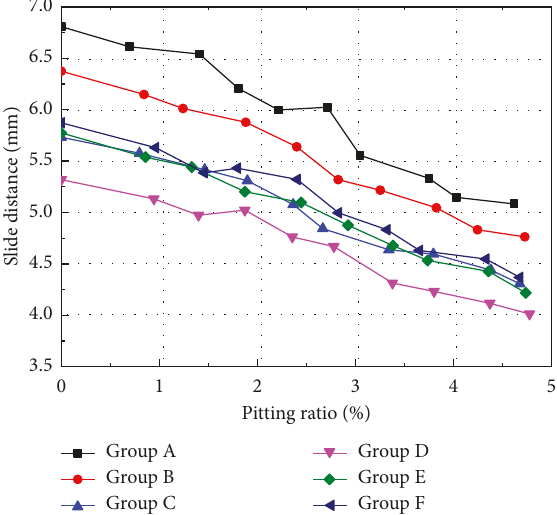
Figure 12: The relationship between pitting ratio and slide